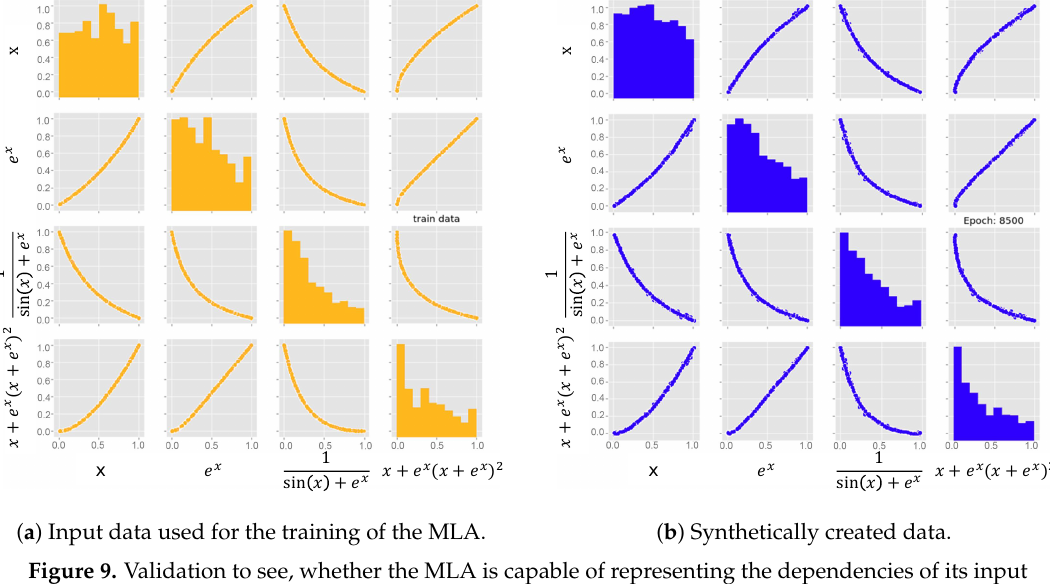
Figure 9. Validation to see, whether the MLA is capable of representing the dependencies of its input data set by applying multiple different interdependent